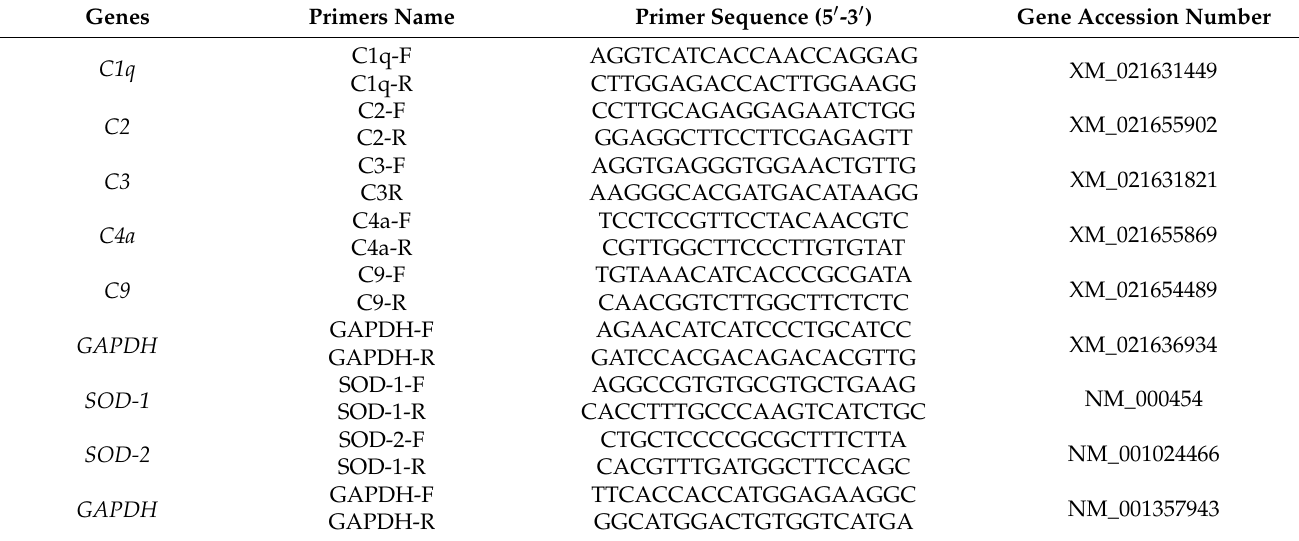
Table 1. Primers